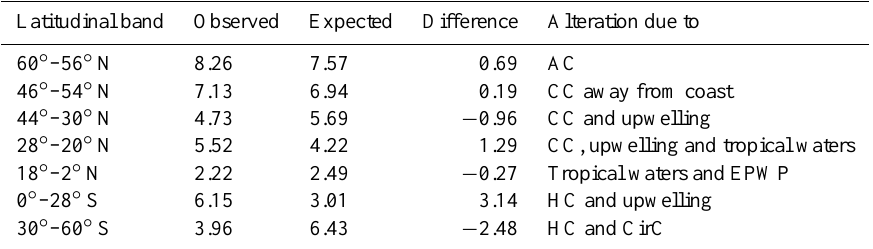
Fig. 1. (a) Mean latitudinal SST range for the selected pixels for the same period (black circles) and the theoretical SST range derived from solar irradiance (red line). (b) Coastal stations (pixels) selected for the study with their mean SST for the 61yr in the data base. Table 1. Observed SST range, expected SST range, range difference and likely cause of such difference for seven latitudinal bands found in the study. AC=Alaska Current, CC=California Current, EPWP=eastern Pacific warm pool, HC=Humboldt or Peru Current, CirC=Circumpolar Current. Latitudinal band Observed Expected Difference Alteration due